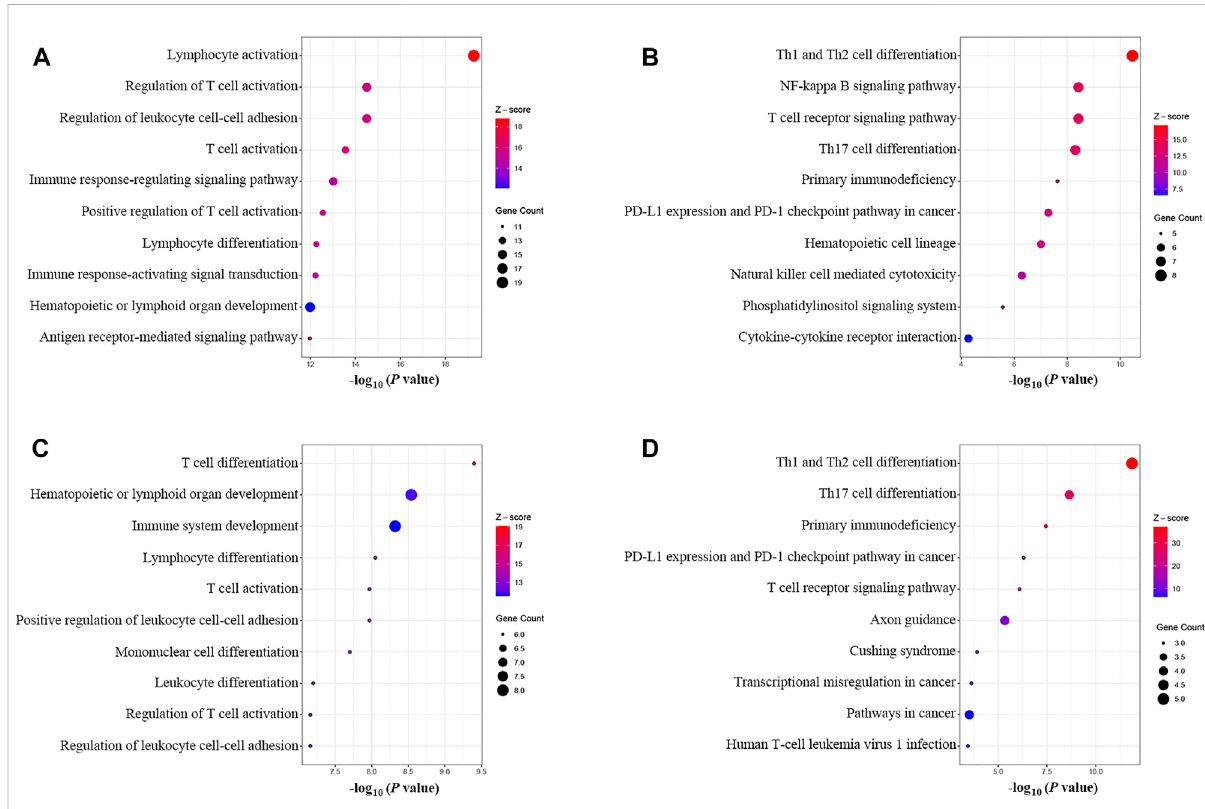
FIGURE 6 GOBPandKEGGenrichmentanalysis. (A) GOBPenrichmentofthePPInetwork. (B) KEGGenrichmentofthePPInetwork. (C) GOBPenrichment of the main gene cluster in the ceRNA network. (D) KEGG enrichment of the main gene cluster in the ceRNA